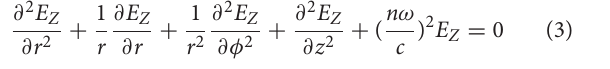
cases [8]. Our concern is the optical power distribution of the optical field in the cross-section of the optical fiber during the transmission of an optical signal in optical fiber. To know the distribution, it is necessary to find the solution for the scalar field of the optical fibers of Equations (1) and (2) that satisfy the core-cladding boundary conditions. In the cylindrical coordinate system (r, φ , z) shown in Figure 3 , Equation (1) can be expanded into a wave equation [5, 6,